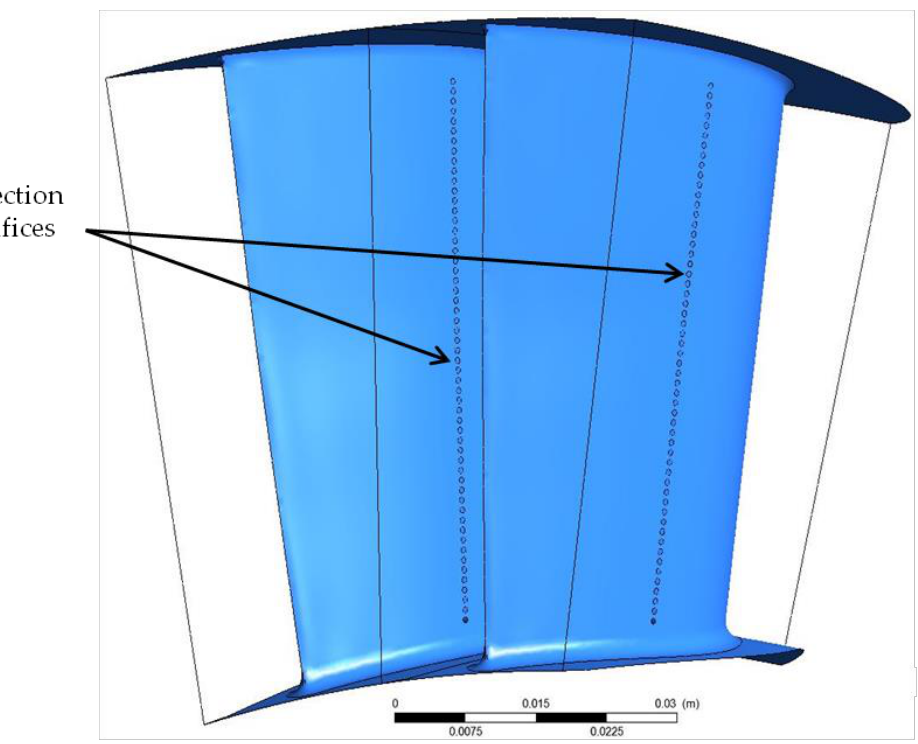
Figure 11. Selected injection configuration.